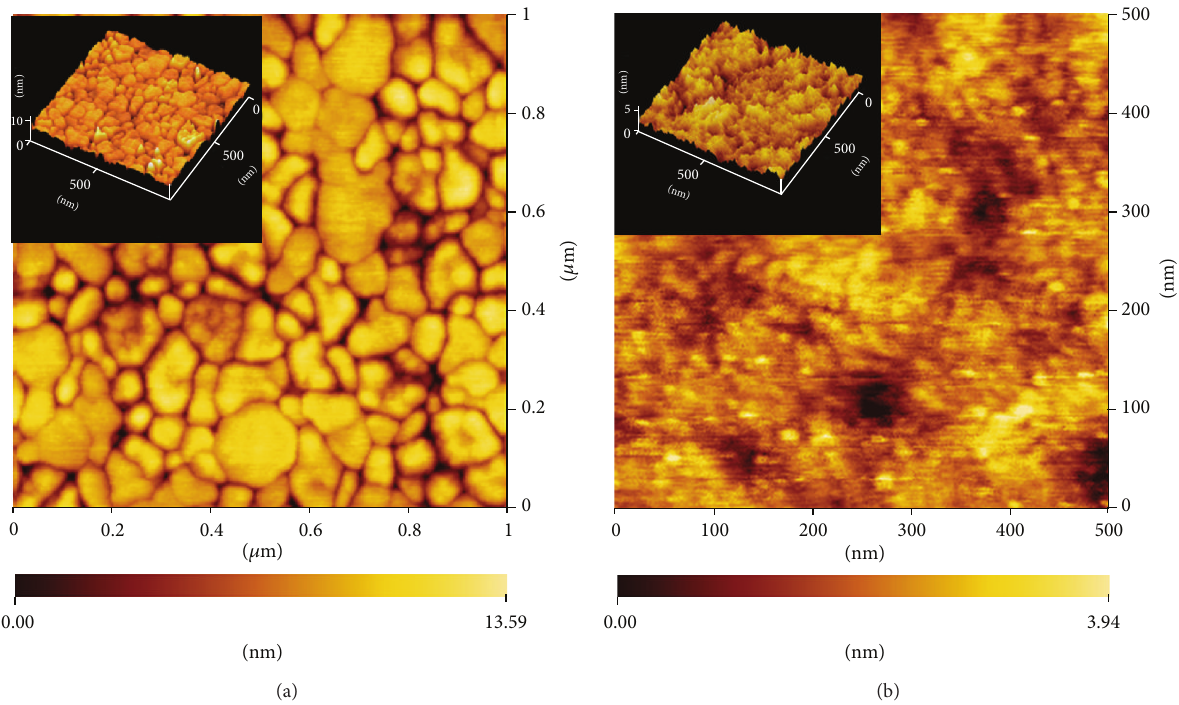
Figure 2: AFM images of (a) PZT and (b) LO/PZT surface. The insets of (a) and (b) are 3D-topography images, respectively.